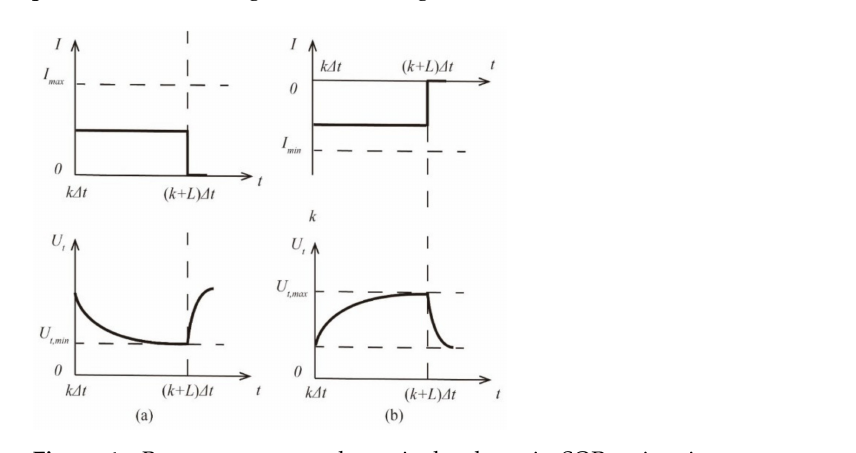
Figure 1. Battery current and temrinal voltage in SOP estimation at a constant current mode: ( a ) discharge; ( b )